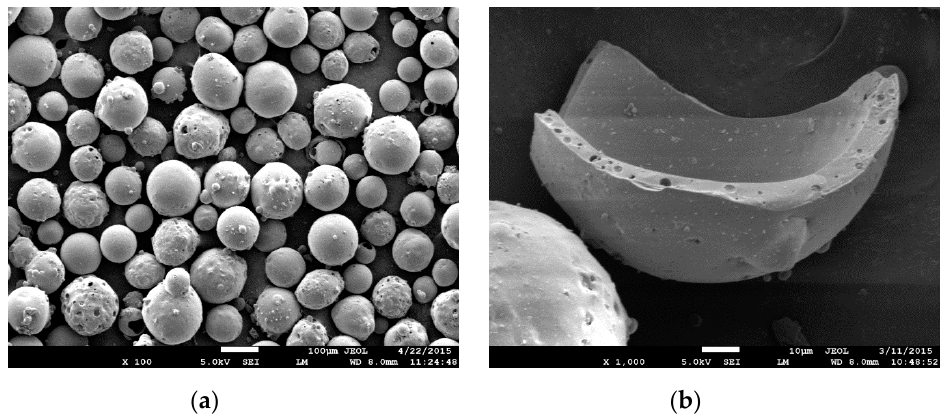
Figure 1. Morphology of ( a ) cement; ( b ) GGBS; ( c ) FA; and ( d ) SF.